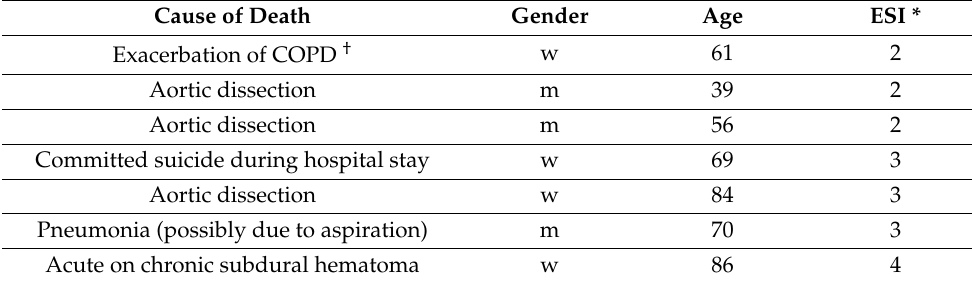
Table A4. Low-risk patients who died.